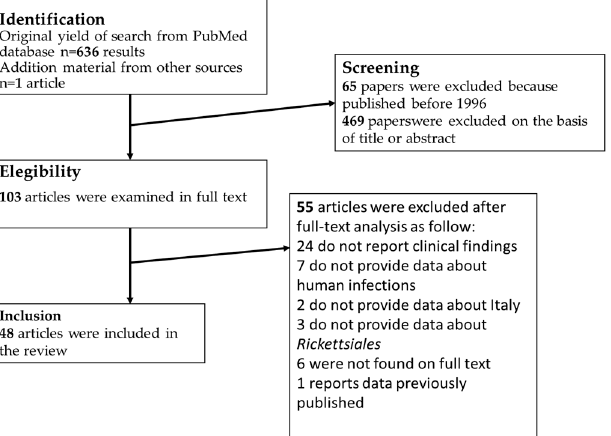
Figure 1. Process of bibliographic research for review about Rickettsiales infections in Italy .